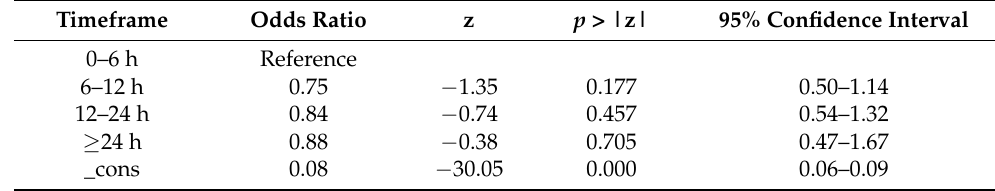
Table 3. The univariate mortality risk according to presentation-to-endoscopy timeframes.